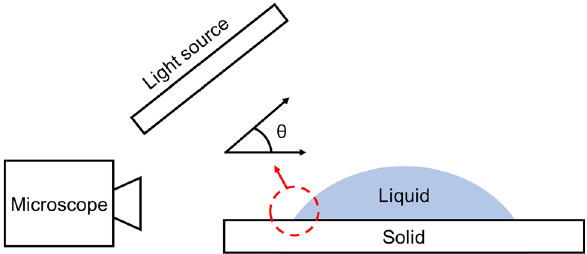
Figure 4. A schematic of the contact angle measurement using the sessile drop method. The contact angle is formed between the liquid–solid–vapor interface.